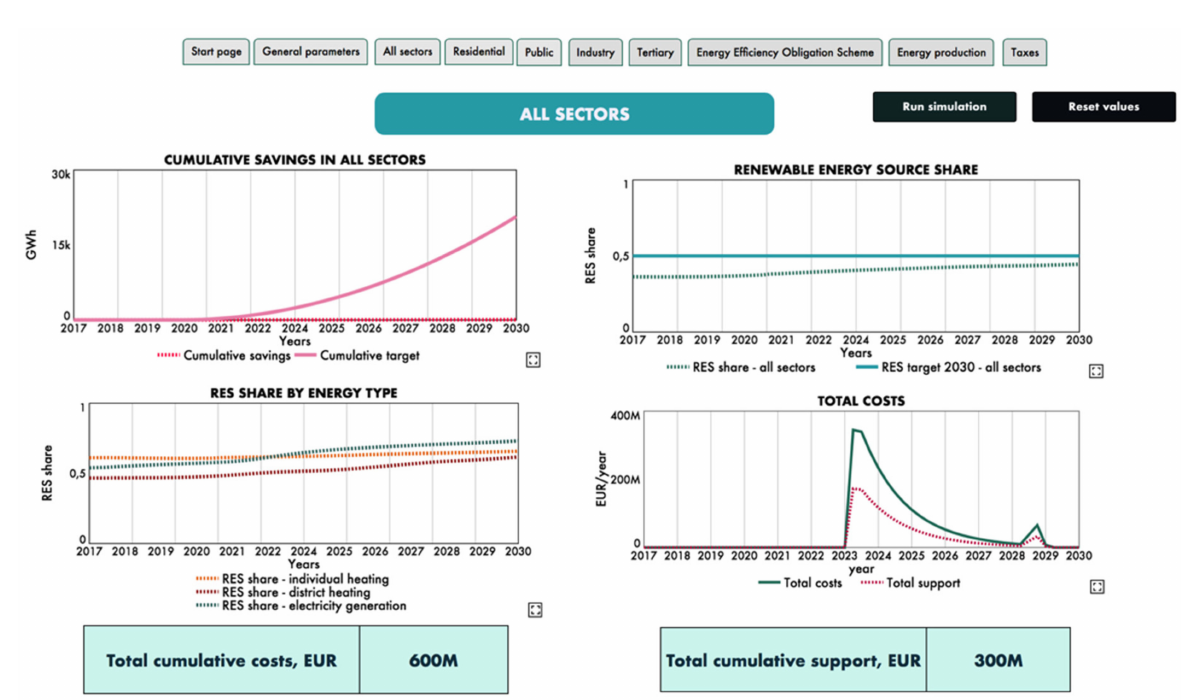
Figure A1. Internet-based model interface page for all sectors.